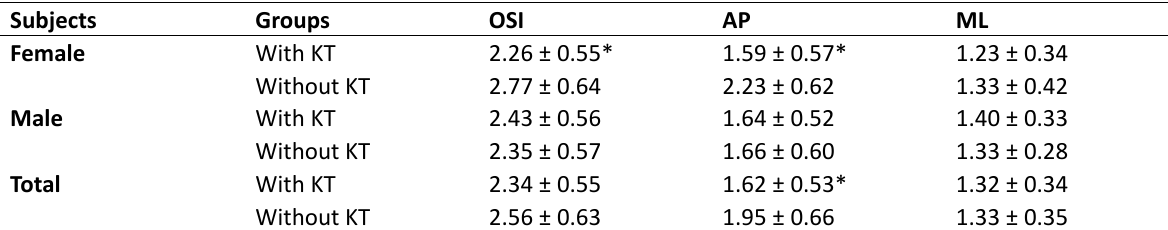
Table 3. Postural control scores with KT and without KT in EC condition (Mean ±